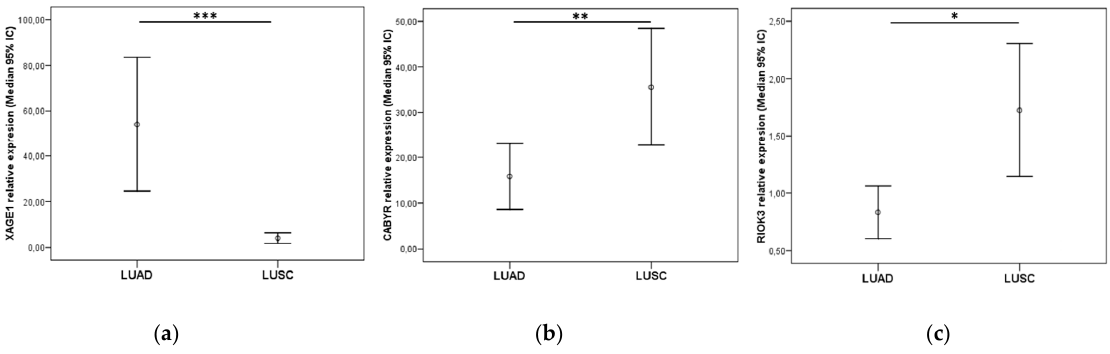
Figure 8. ( a ) XAGE1 relative expression in the resected NSCLC LUAD cohort and ( b ) CABYR and ( c ) RIOK3 in the LUSC cohort. Graphics represent median with 95% CI (confidence interval). p -values were obtained using Mann–Whitney U-test. Significance values were * p < 0.05, ** p ≤ 0.01, and *** p ≤ 0.001. NS: Non-significant.